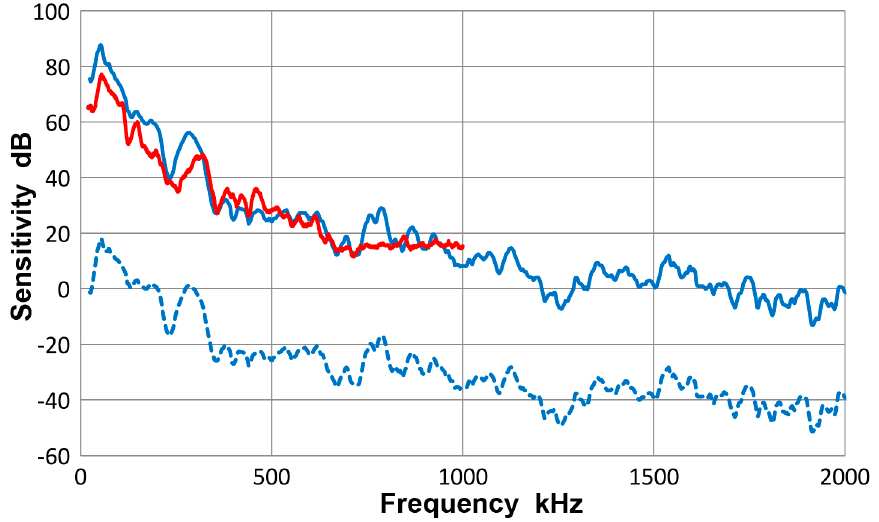
Figure 15. Receiving sensitivity of PAC R6a sensor. Blue dash -averaged guided wave displacement sensitivity, blue -Velocity response of the averaged curve, red -surface wave velocity response supplied by PAC.